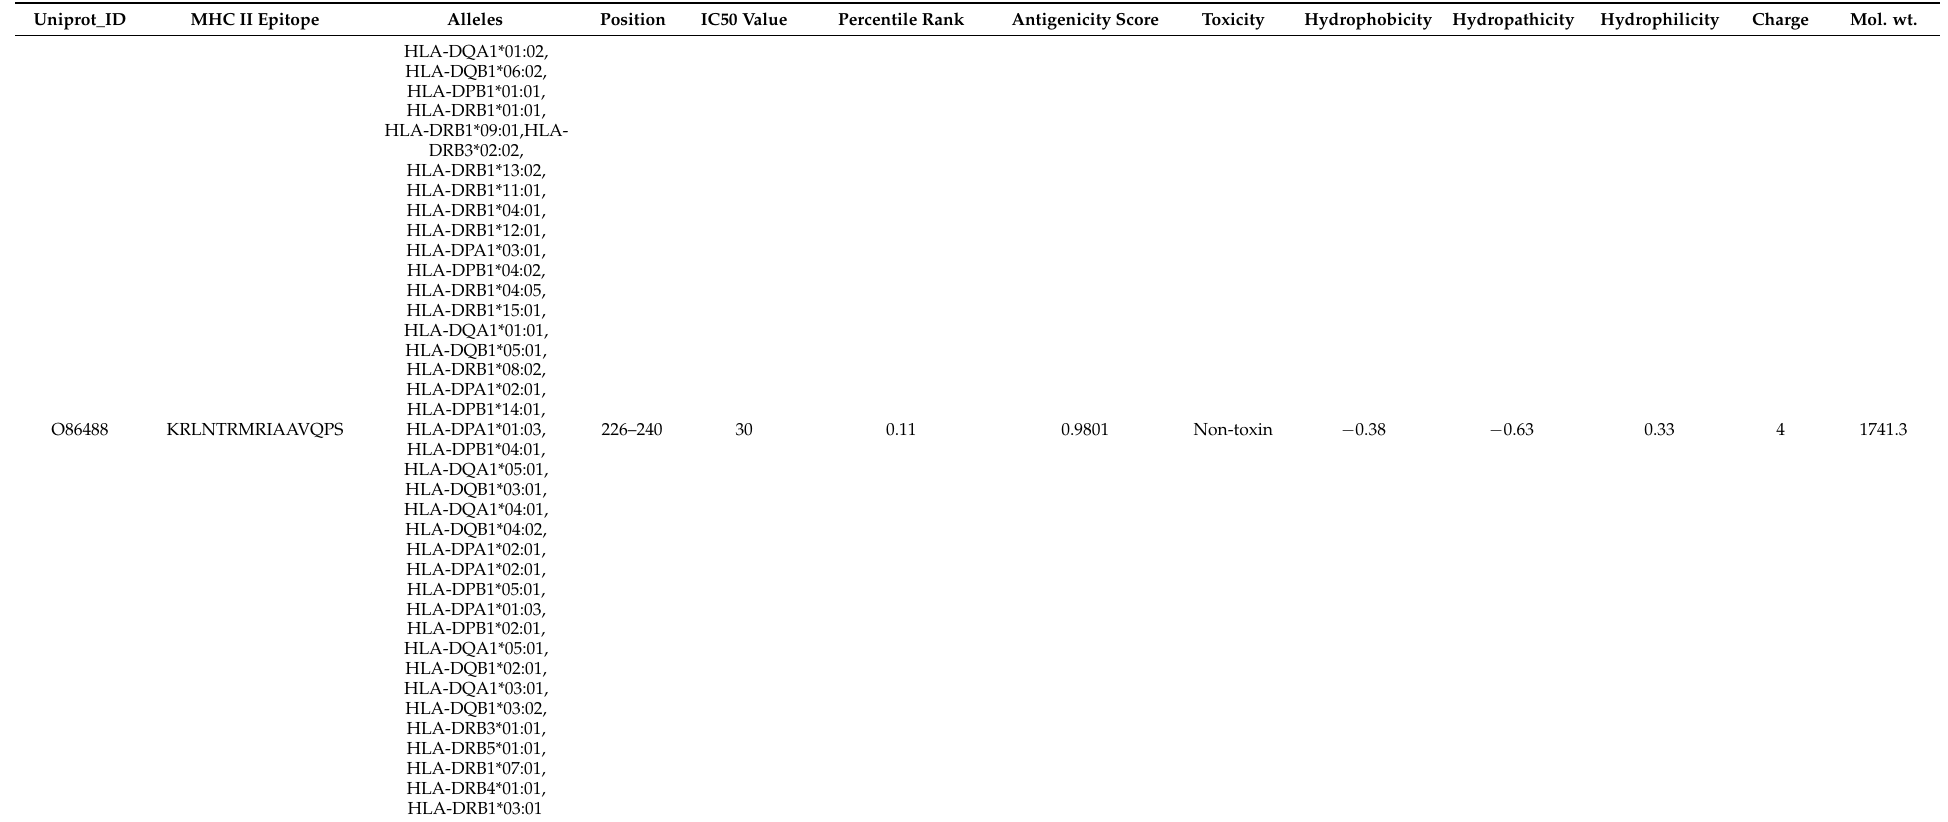
Table 3. Predicted HTL epitopes from S. aureus cell wall adherence proteins, SdrD and SdrE to design a multi-epitope vaccine construct with their corresponding MHC Class II alleles and their immunogenic